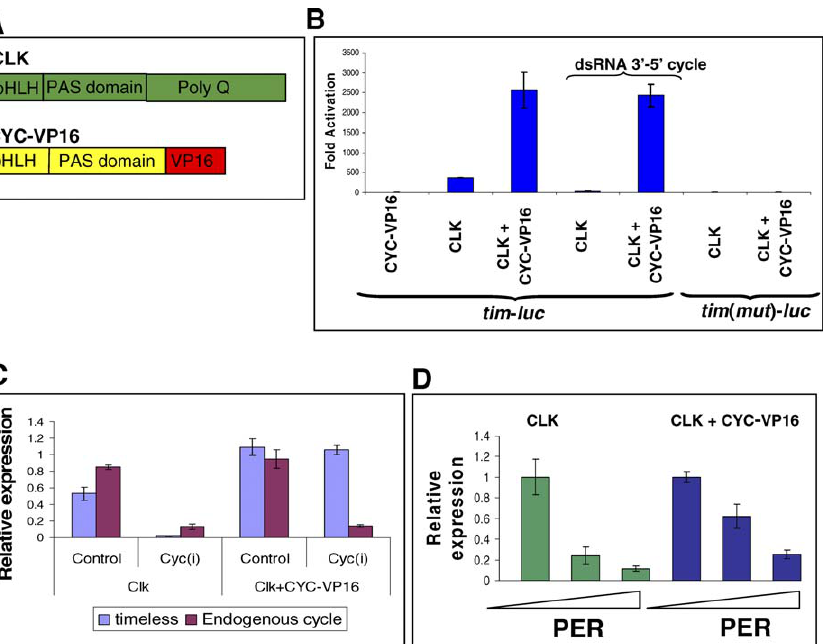
Figure 1. CYC-VP16 Increases the Transcriptional Strength of CLK–CYC Heterodimer (A) Schematic diagram of the CLK protein (top) and of the CYC-VP16 hybrid protein (bottom) showing the protein domains of those molecules. (B) Effect of cyc - vp16 expression (100 ng of cyc - vp16 -expressing plasmid, pAc - cyc - vp16 ) and/or Clk expression (10 ng of pAc - Clk ) on the transcription of tim-luc (first five bars) or tim ( mut )- luc (last two bars) in S2 cells. Some cells were treated with dsRNA against the 5 9 and 3 9 UTR regions of the cyc gene as described in the Materials and Methods section (fourth and fifth bars). In all cases, cotransfection with pCopia-Renilla luciferase was performed to normalize for cell number, transfection efficiency, and general effects on transcription. For each condition a normalized firefly/ Renilla luciferase value was obtained by setting the ratio without any addition of cyc-vp16 or clk to 1. A representative experiment is shown. For each condition two experiments with duplicates were performed. Error bars represent standard error of the mean. (C) Similar experiment to the one performed in (B) but assessing the levels of tim and cyc mRNAs by real-time PCR. Control or cyc (i) refers to dsRNAs against green fluorescent protein or untranslated regions of cyc . Expression values are reported as a ratio of tim or cyc over control ( rp49 ). The experiment was performed twice, and the results were averaged. The error bars indicate standard error of the mean. (D) PER repression of CLK-mediated transcription in presence (100 ng of pAc - cyc - vp16 ) or absence of cyc - vp16 ; 0, 50. or 150 ng of pAc - per were used. For each condition a normalized firefly/ Renilla luciferase value was obtained by setting the ratio with the addition of pActin - Clk to 1. A representative experiment is shown. Two experiments with duplicates for each condition were performed.